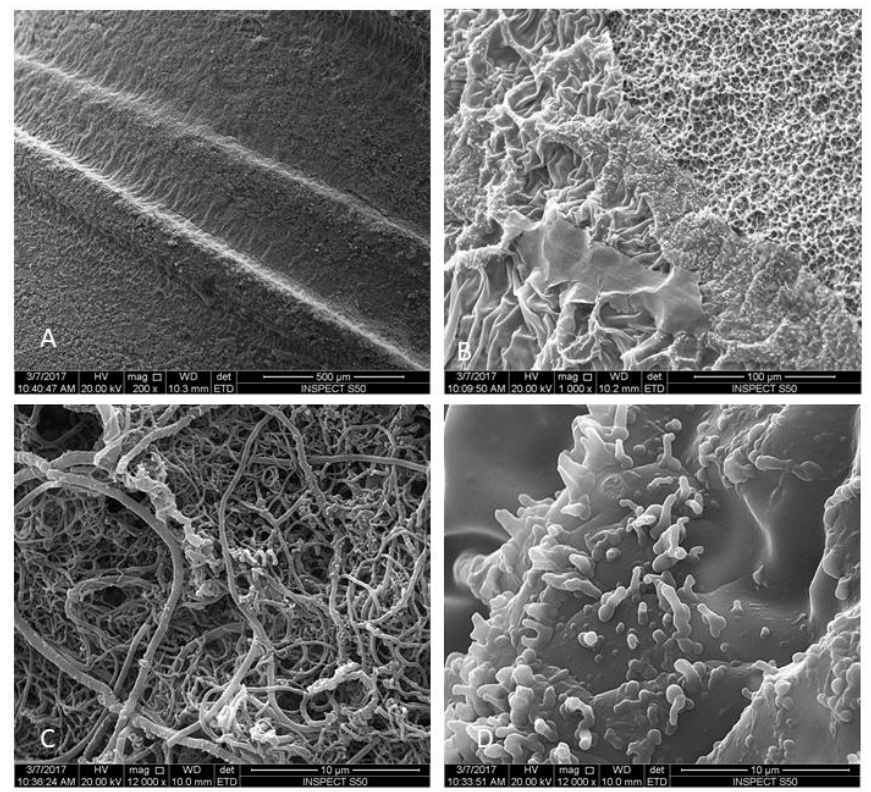
Figure 2. Scanning electron micrographs of MTX implants after bacterial contamination Group V. Low magnification showing the biofilm formation on implant threads: ( A ) 200 × ; and ( B ) 1000 ×